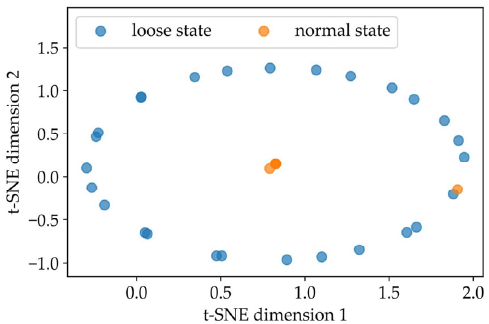
Figure 8. Clustering visualization results of fastener state feature based on t-SNE.